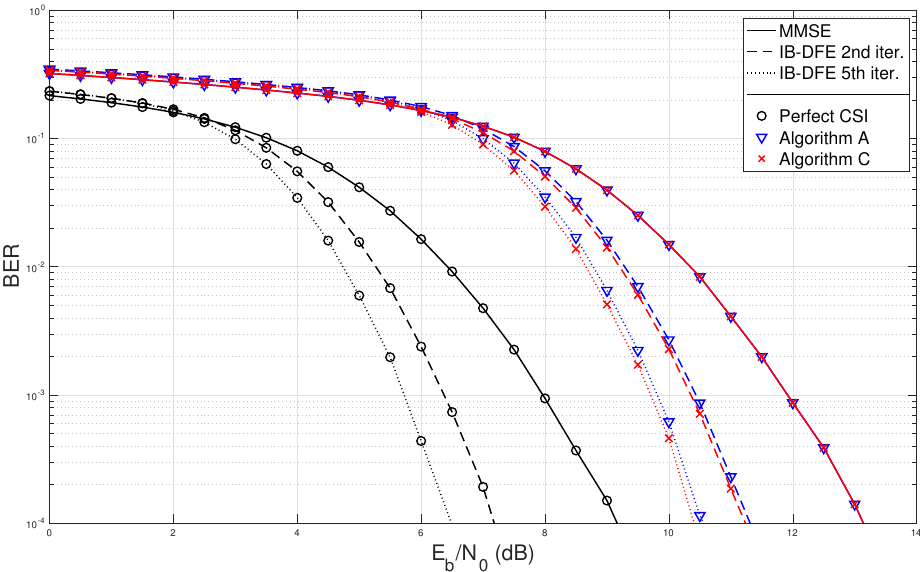
Figure 6. BER results for TIBWB–OFDM with IB–DFE over a dispersive channel employing Algorithm C for a ZC preamble having the same average power as data symbols.